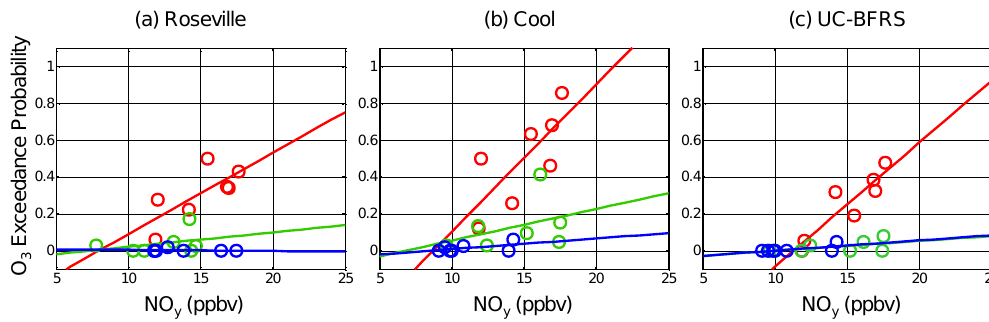
Fig. 5. O 3 exceedance probability (90ppb 1h standard) for hot (red), medium (green), and cold (blue) temperature days vs [NO y ]. Open circles are annual mean exceedance probabilities and [NO y ] is calculated as in Fig. 2, separated by temperature. Data shown for (a) Roseville, (b) Cool, and (c)